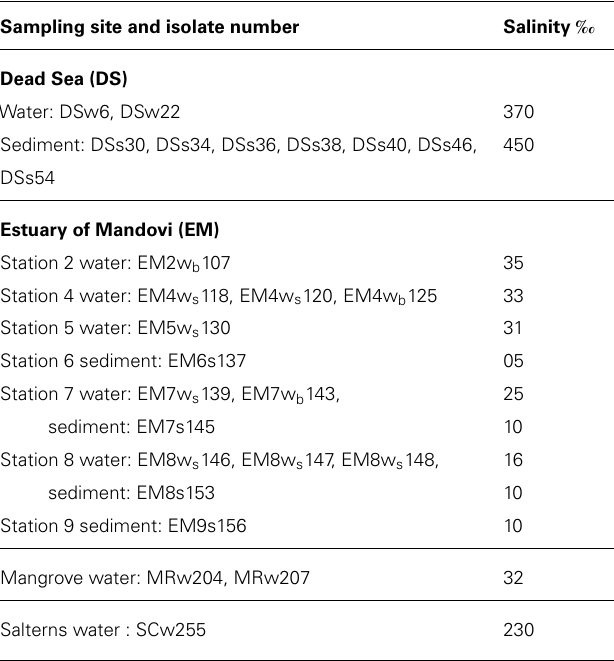
Table 1 | Isolates obtained from various econiches of different